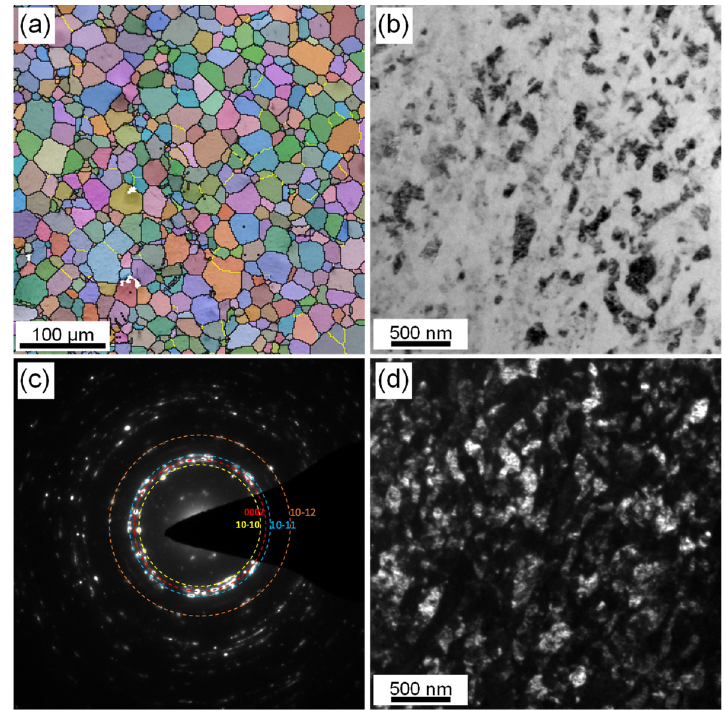
Figure 2. ( a ) EBSD Euler map of the coarse-grained Mg–Gd–Y–Zr alloy; ( b – d ) TEM bright field, SAED, and dark field images of the nanocrystalline Mg–Gd–Y–Zr